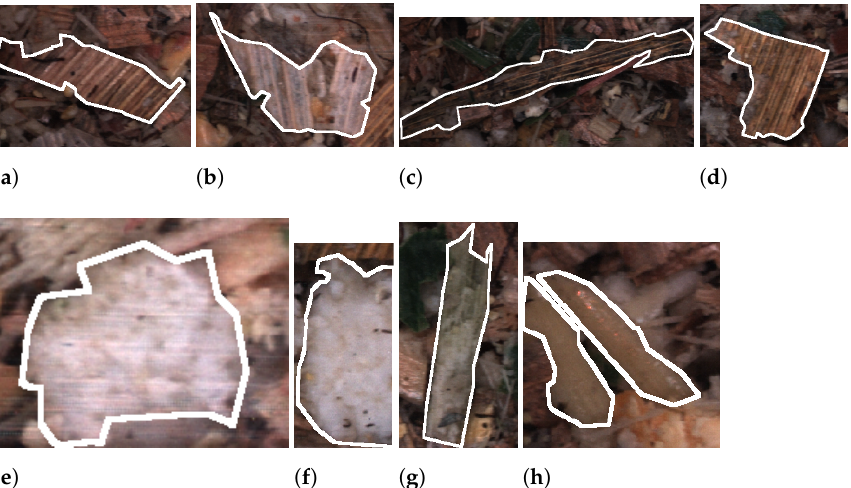
Figure 9. Overlength class examples, accepted leaves ( a , b ), non-accepted leaves ( c , d ), inner stalk ( e , f ), and outer stalk ( g , h ). Annotations examples are all from images captured of WPCS harvested at a TLOC of 4 mm.